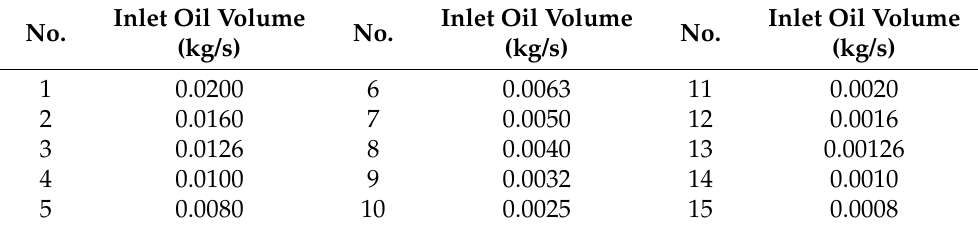
Table 4. Division of discrete nodes of inlet oil volume in the oil loss